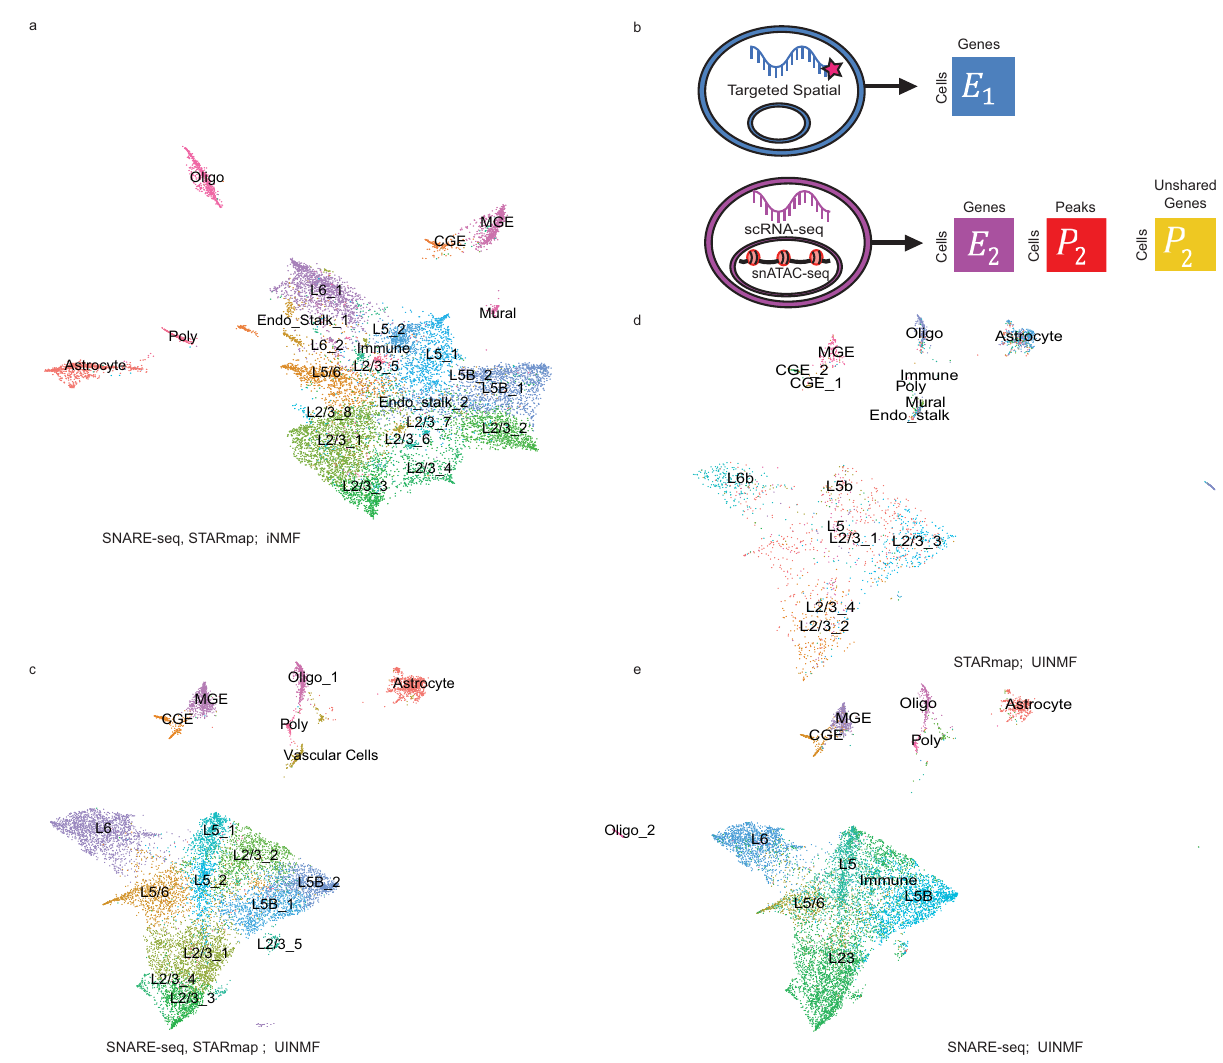
Fig. 6 Incorporating unshared chromatin and gene features to integrate spatial transcriptomic and multimodal data. a UMAP for iNMF integration of STARmap spatial transcriptomic data and SNARE-seq RNA data only, annotated by jointly examining the SNARE-seq and STARmap labels. b Schematic of how unshared gene and chromatin accessibility data is incorporated into the integration analysis of STARmap and SNARE-seq using UINMF. c The integration is improved signi fi cantly by the inclusion of ATAC gene-centric features in the U matrix, annotated by jointly examining the SNARE-seq and STARmap labels. d – e The original cell type labels of STARmap cells ( d ) and SNARE-seq cells ( e ) show clear correspondence after UINMF